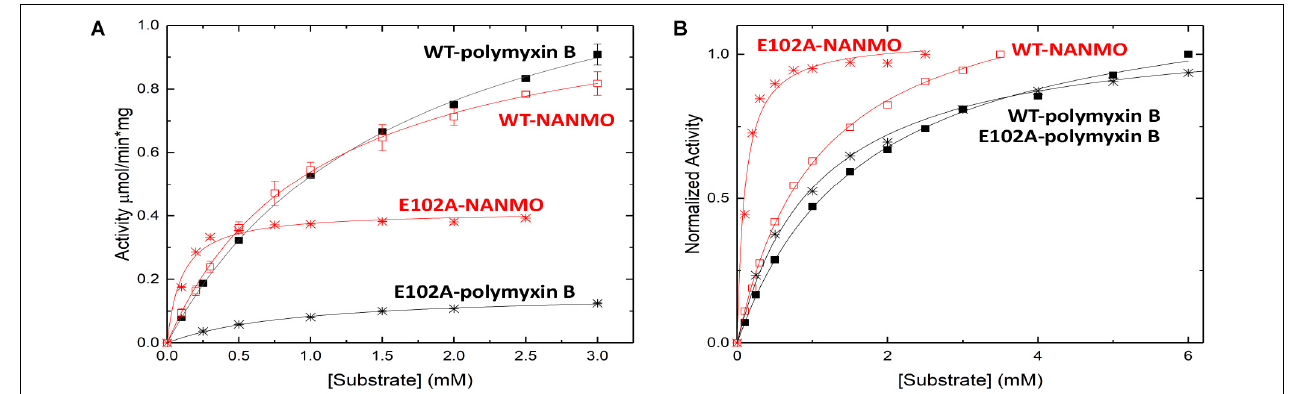
FIGURE 2 | Substrate saturation curves of PA3944 WT and E102A mutant toward polymyxin B and NANMO. The concentration of acceptor substrate was varied while AcCoA was held constant at 0.5 mM. Curves in black correspond to polymyxin B as the substrate and curves in red correspond to NANMO as substrate. WT is shown as solid squares for polymyxin B and open squares for NANMO, E102A is shown as black stars for polymyxin B and red stars for NANMO. (A) Substrate saturation curves. (B) Normalized data from substrate saturation curves.